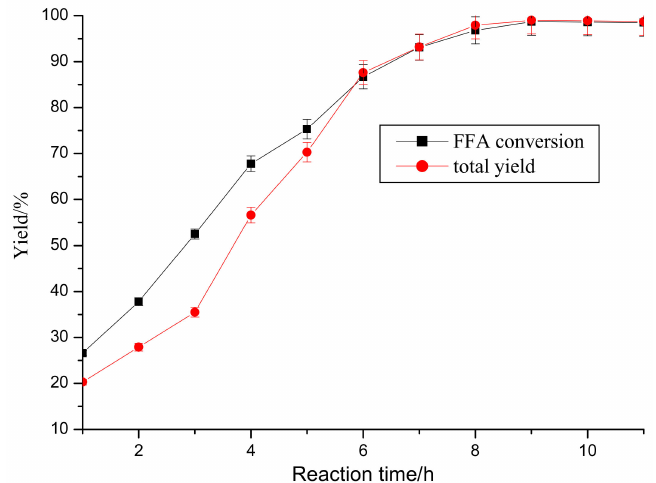
Figure 4. The catalytic activity of the novel magnetic carbon microtube-based solid acid a,b . a The reaction conditions: cooking oil—5 g, methanol—3.01 g, catalyst usage—0.04 g, 70 ◦ C; b The yield was calculated on GC using internal standard method.